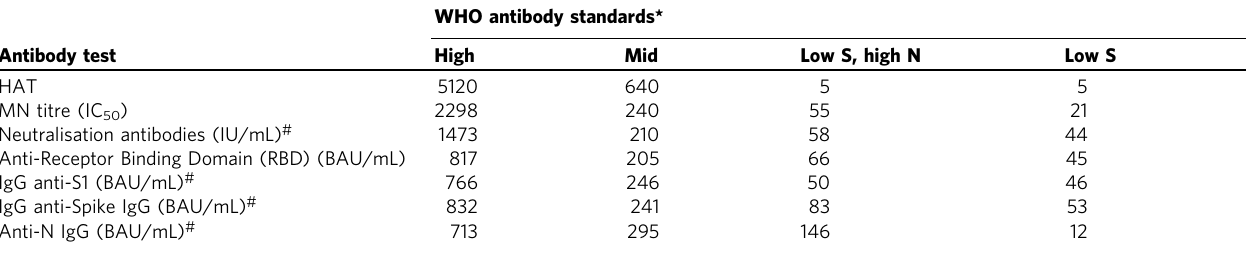
Table 2 Comparison of the haemagglutination test antibody endpoint titres to the neutralisation and binding antibodies in the WHO anti-SARS-CoV-2 international